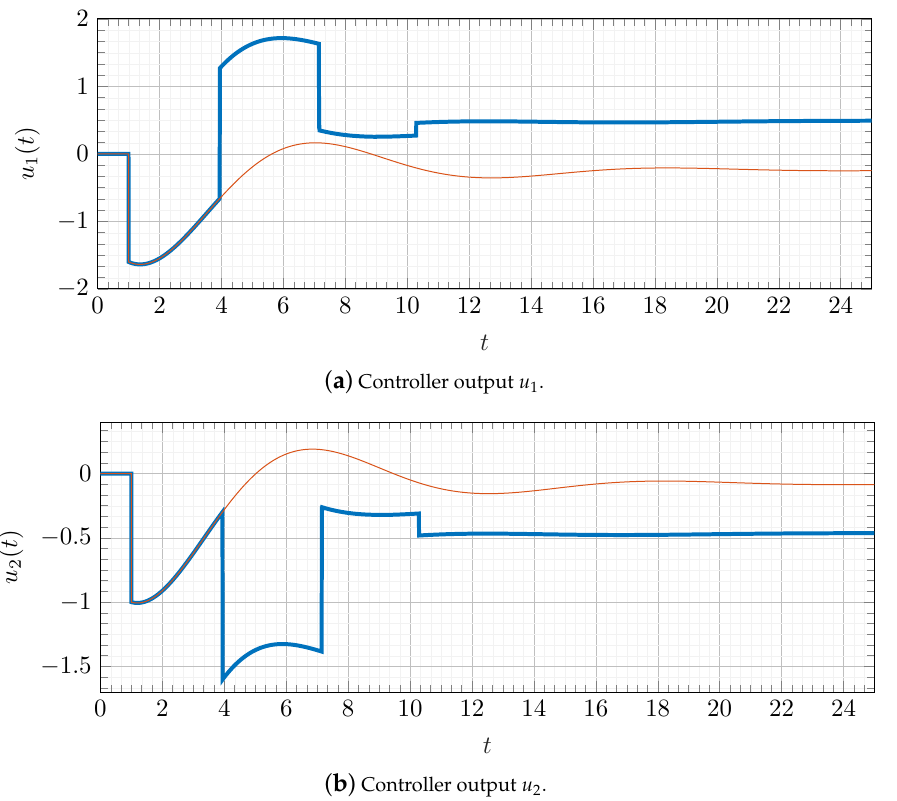
Figure 10. Controller outputs for the step response: (orange thin line) base PI controllers; (blue thick line) PI + CI